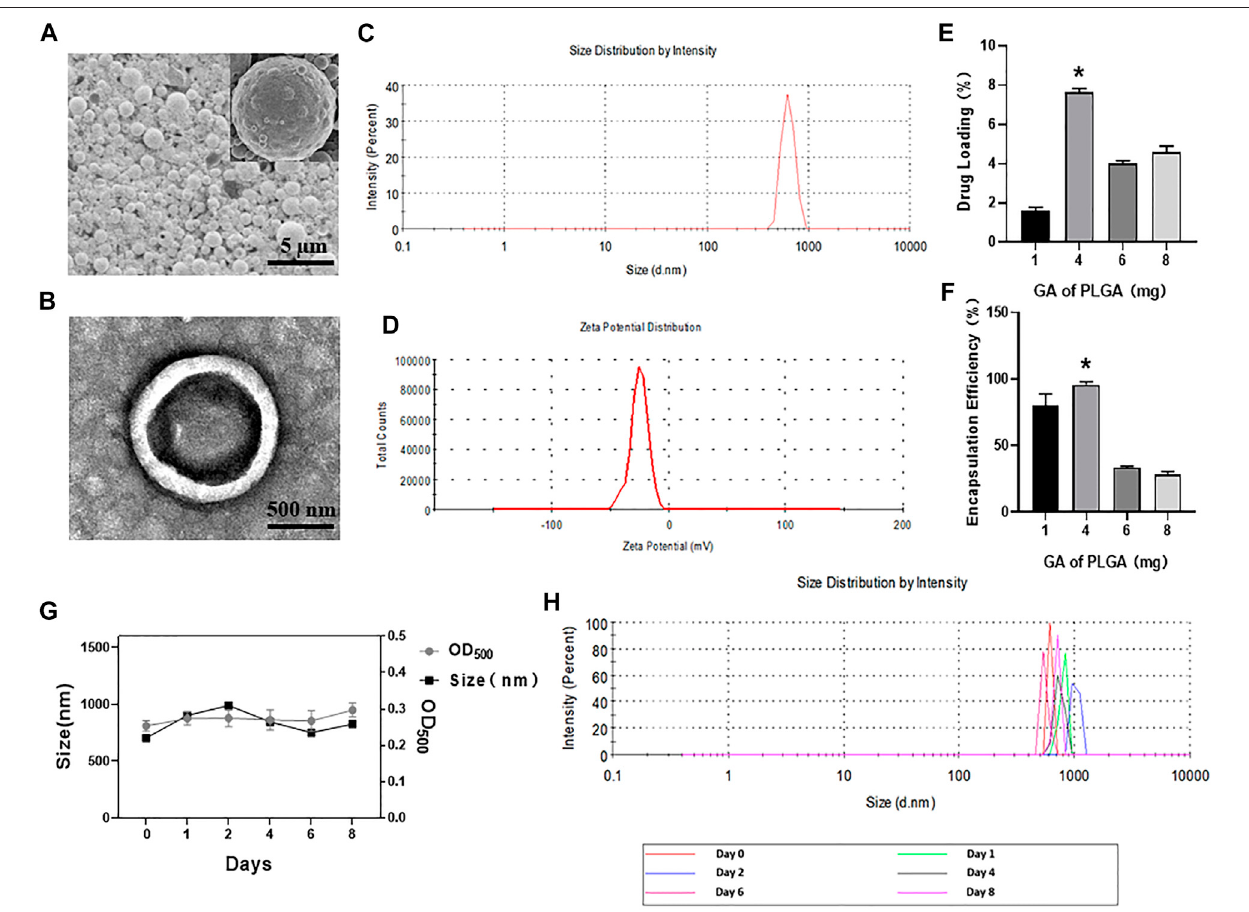
FIGURE 1 | (A) SEM images of GA porous-lipid/PLGA MBs. (B) TEM images of GA porous-lipid/PLGA MBs. (C) Size of GA porous-lipid/PLGA MBs. (D) Zeta potentialofGAporous-lipid/PLGAMBs. (E) DrugloadingofGAporous-lipid/PLGAMBs.Comparedwithothergroups,thedrug-loadingratecorrespondingtothe4 mg of GA plus 50 mg of PLGA is 7.65 ± 0.15% (* p < 0.05 versus other three groups). (F) Encapsulation ef fi ciency of GA porous-lipid/PLGA MBs. Compared with other groups, the encapsulation ef fi ciency corresponding to the 4 mg of GA plus 50 mg PLGA is 95.57 ± 1.89% (* p < 0.05 versus other three groups). (G) The particle size and concentration of GA porous-lipid/PLGA MBs were measured at the 0th, 1st, 2nd, 4th, 6th, and 8th day. The concentration of GA porous-lipid/PLGA MBs is expressed by OD 500 . (H) The particle size distribution of GA porous-lipid/PLGA MBs on the 0th, 1st, 2nd, 4th, 6th, and 8th